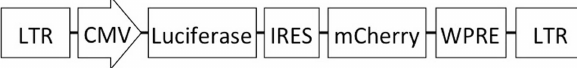
Figure 1. Schematic of the lentiviral vector used in this study. The vector contains an effLuc expression cassette, expression of which is driven by the CMV promoter. An internal ribosomal entry site (IRES) and a mCherry cassette are downstream of luciferase. This vector contains the SIV promoter in the 5 9 long-terminal repeat (LTR) for efficient virus production in the context of a Tat-free packaging system, and self-inactivating mutations in the 3 9 LTR.